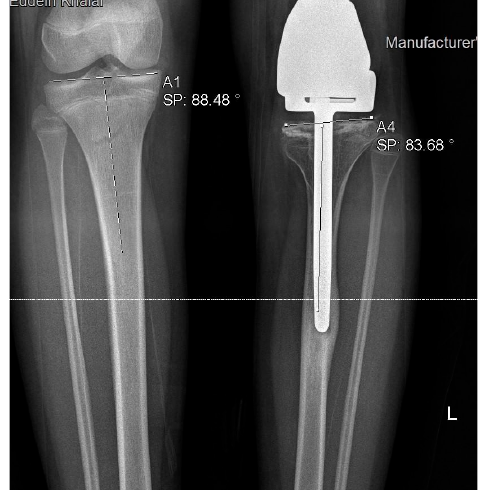
Figure 6. Coronal varus deformity in one of our